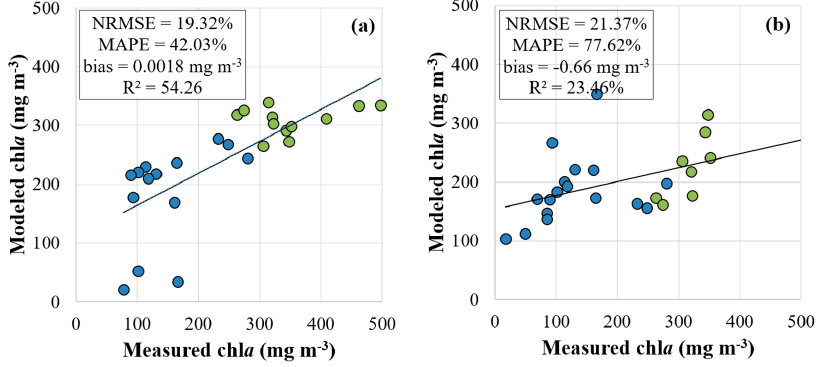
Figure 4. Chl a retrieval algorithm fitted using a ( λ ) values that were derived from scattering correction methods: ( a ) flat and ( b ) proportional.